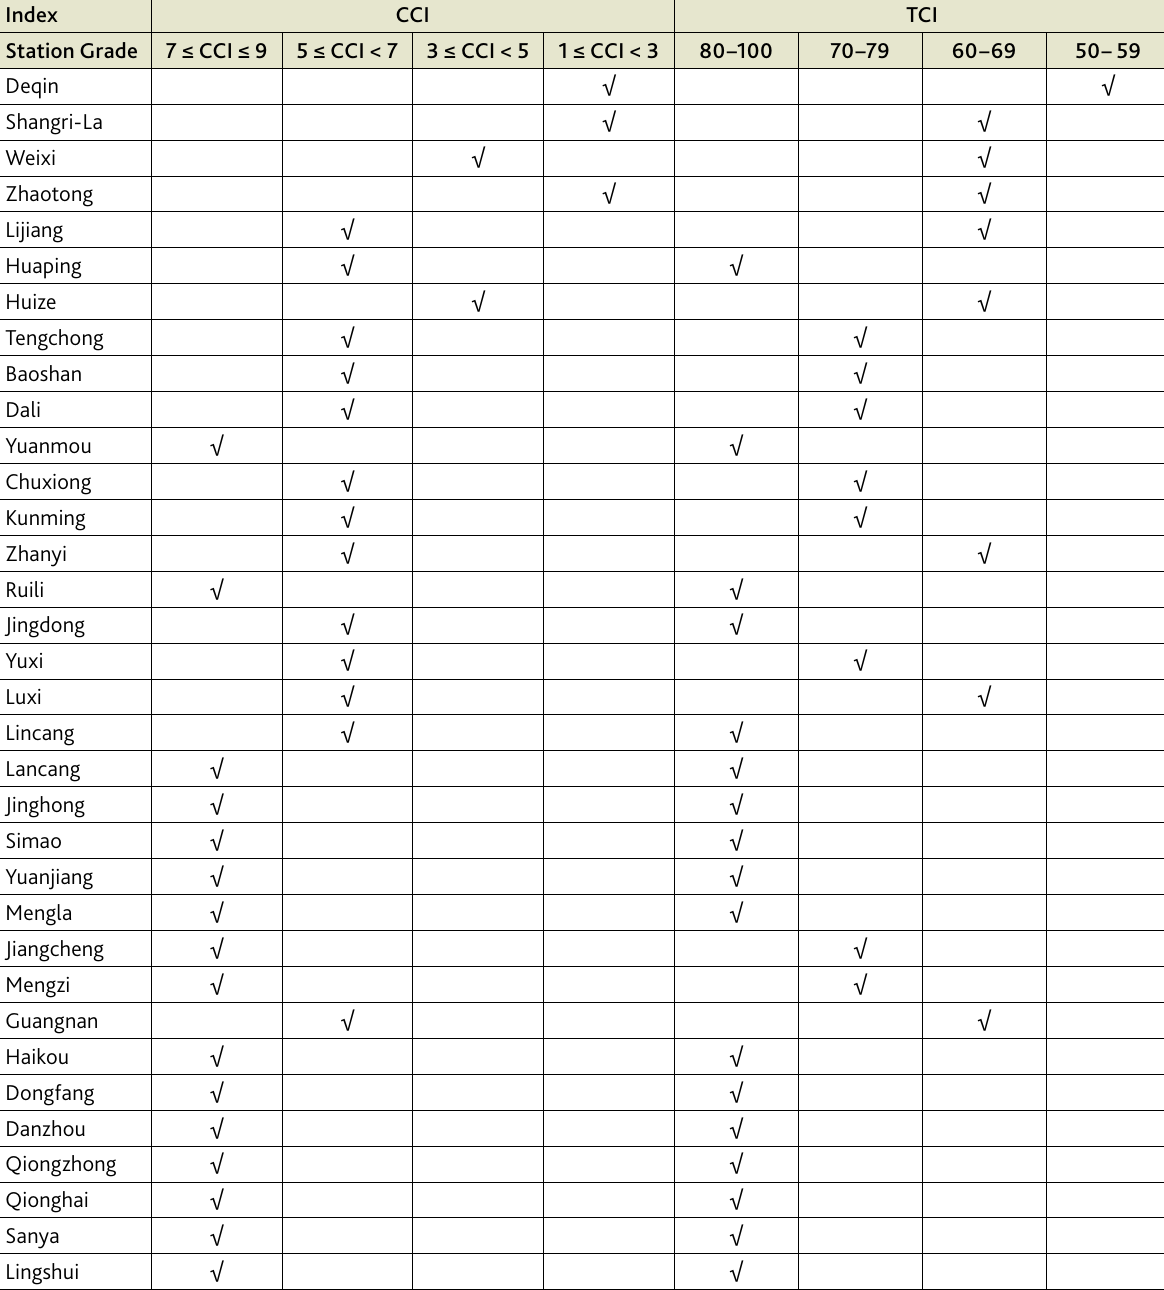
Table 4. January CCI and TCI classifications for Yunnan (first 27 stations) and Hainan (last 7 stations) provinces between 1981 and